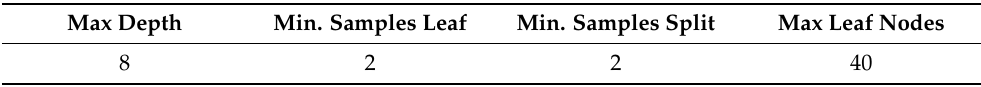
Table 2. Hyperparameters setting of decision